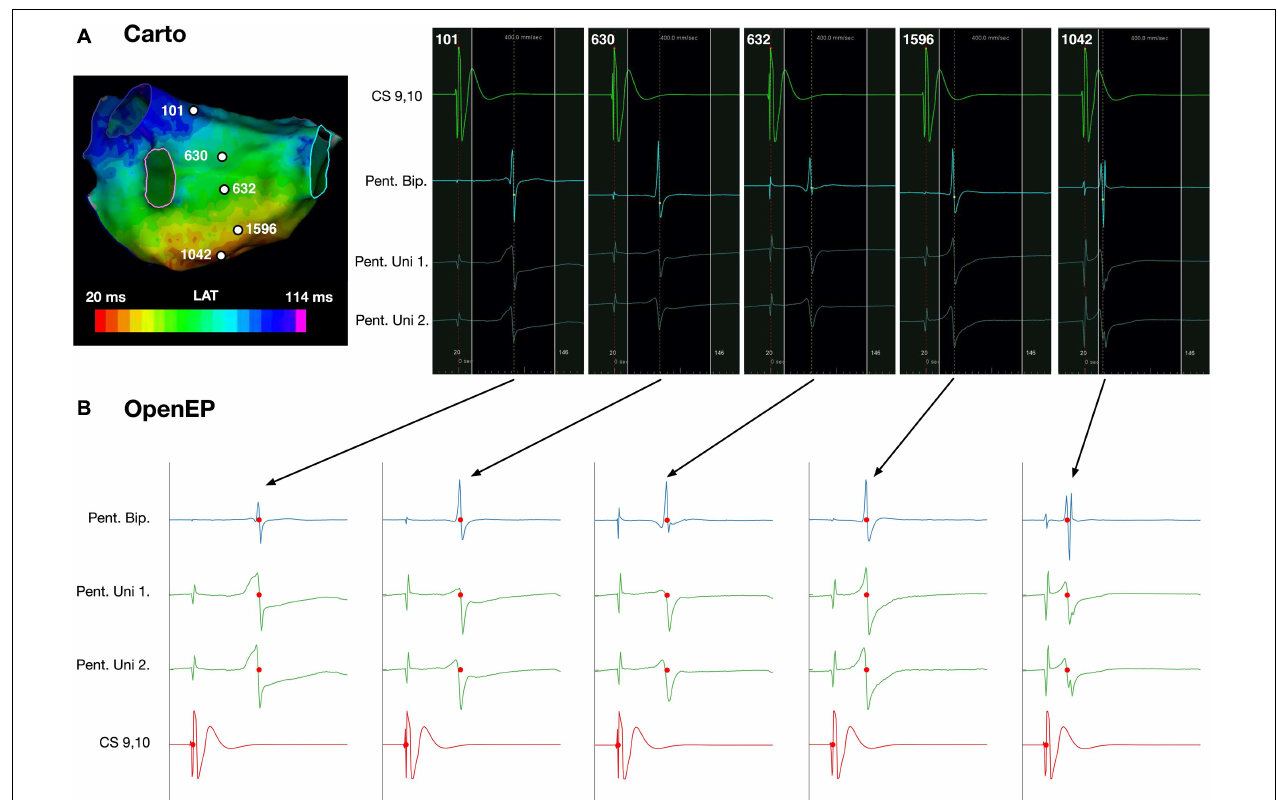
FIGURE 12 | Display of electrogram data using OpenEP. (A) Reference, bipolar and unipolar electrogram data at five selected sites on the posterior wall of a left atrium. (B) Corresponding electrograms extracted and plotted using OpenEP. Blue – bipolar electrogram; green – paired unipolar electrograms; red – reference coronary sinus electrogram. Red dots indicate the activation time annotations extracted from the clinical mapping platform. OpenEP function example: plotOpenEPEgms[userdata, 'iegm', getIndexFromCartoPointNumber(userdata,1042)] . LAT, local activation time; CS, coronary sinus; Pent, PentaRay; Uni, Unipole; Bip,